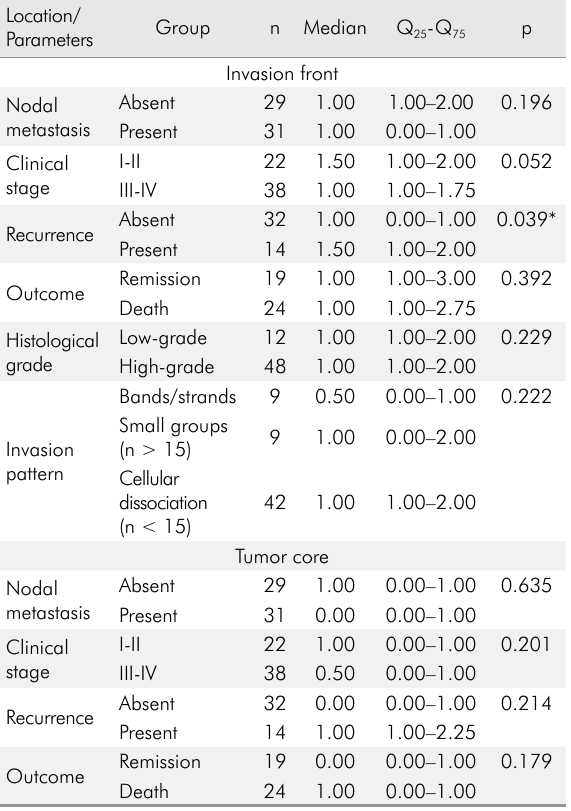
Table 4. Immunopositivity of uPAR at the invasion front and in the tumor core according to the clinicopathological